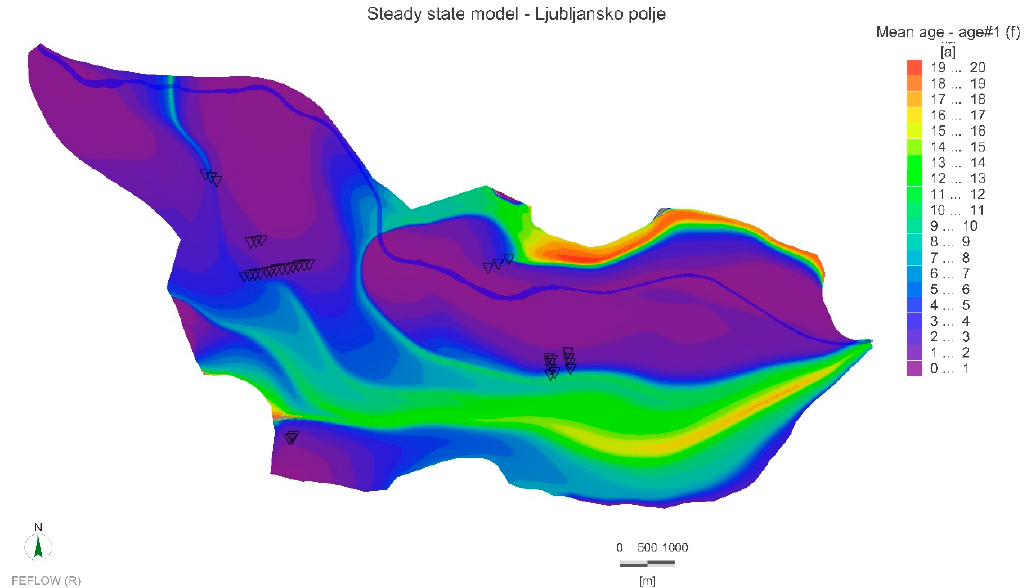
Figure 9. Simulated mean residence time. Black triangles show positions of pumping wells. The steady-state model gives a clear picture of groundwater flow recharge areas and BC. However, for understanding the system in time and under diverse climatic conditions, a transient state GW flow model is required.